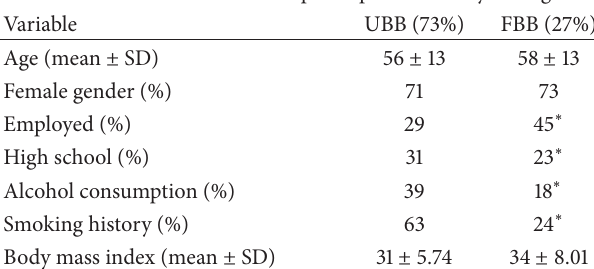
Table 1: Comparison of sociodemographic and health risk data of US-born black versus foreign-born black participating in the CAATCH.